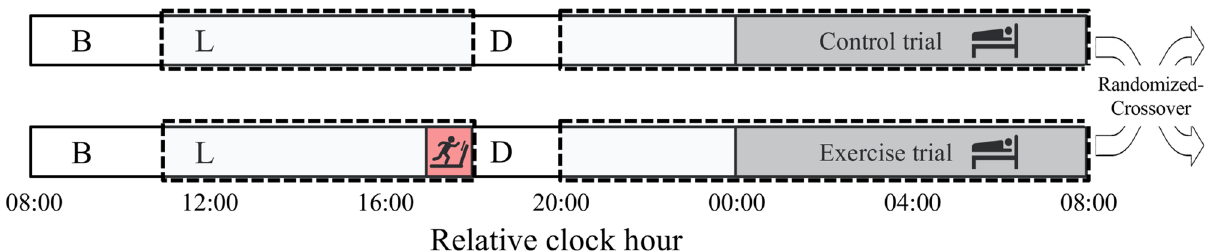
Figure 1. Study protocol. The schedule of the control day (upper bar) and exercise day (bottom bar). For participants whose habitual bedtime is at 00:00, indirect calorimetry begins at 11:00 and ends at 08:00 of the next morning, as shown by the dotted rectangles. Participants exited the metabolic chamber at 19:00 for preparation of the polysomnographic measurement and reentered at 21:00. Gray, red, and white boxes represent sleep (00:00–08:00), exercise (17:00–18:00), and wakefulness (08:00–24:00), respectively. Breakfast, lunch, and dinner are denoted by B, L, and D,